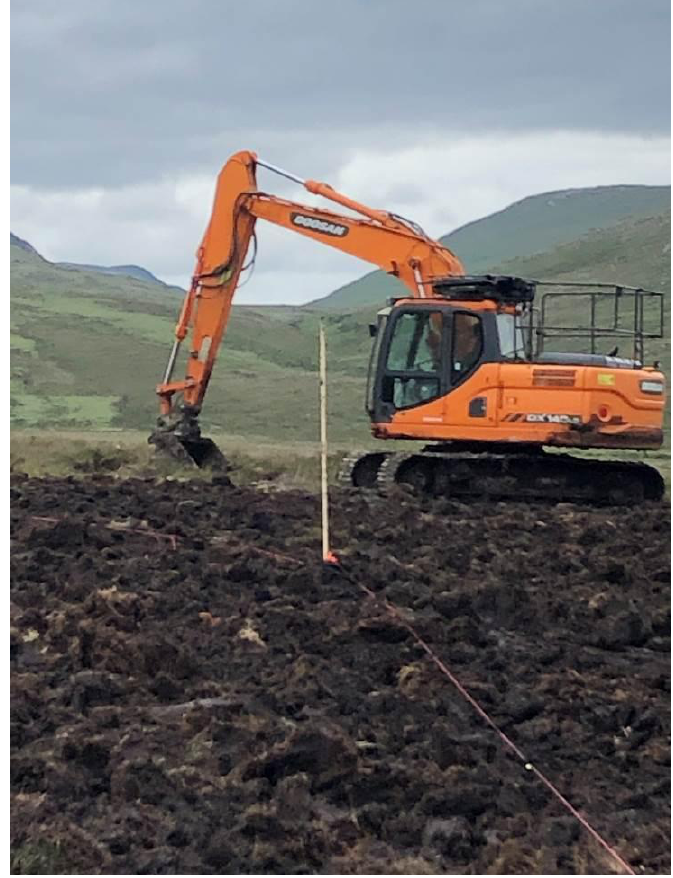
Figure A4. Wooden stake and three survey lines mark the center of the original impact crater for subsequent expeditions to extend the investigation into the granite bedrock below 6.5-m depth.